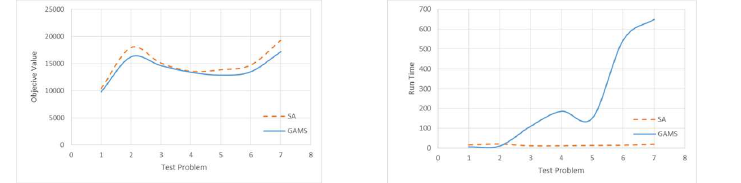
Fig. 8. Run time for P 1 to P 7 (SA and GAMS)